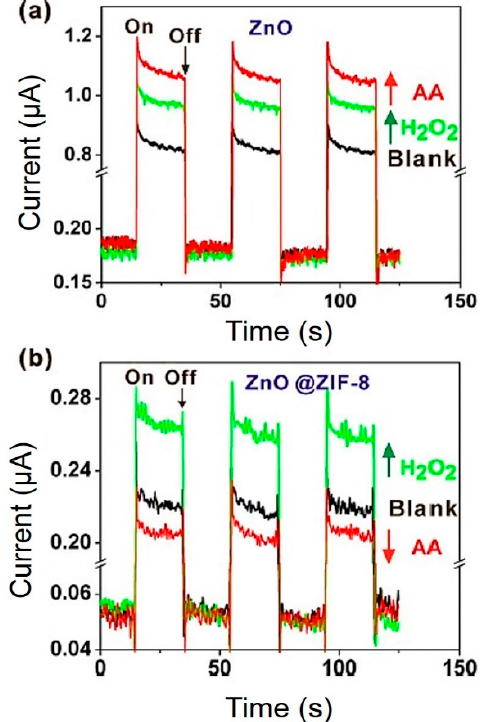
Figure 5. Photocurrent response of the ZnO nanorods ( a ) and ZnO-nanorodes@ZIF-8 ( b ) in the presence of H 2 O 2 (0.1 mM). Reprinted from [110]. Copyright (2020), American Chemical Society.